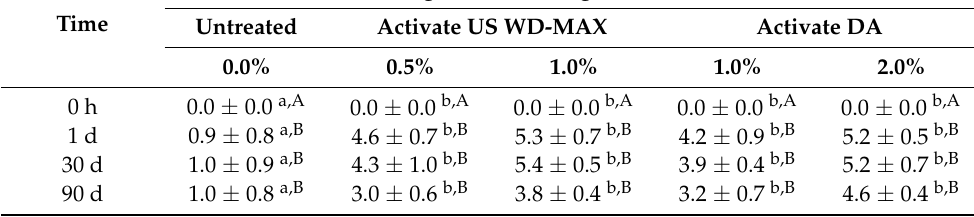
Table 7. Mean logarithmic reduction of Salmonella counts in pet food kibble treatments with inclusion of organic acid mixtures Activate DA at 1% and 2% and Activate US WD-MAX at 0.5% and 1% concentrations as coating, in comparison with untreated (0% organic acid), showing residual effect of treatments over 1, 30 and 90 days during storage. The logarithmic reductions were calculated as the difference between Salmonella counts in the inoculum (8 log CFU/mL) and on the kibbles (untreated and treated). A negative control consisted of canola oil-coated kibble (no organic acid, no inoculation). Salmonella Log Reduction (log CFU/mL) (Mean ± SE) Time